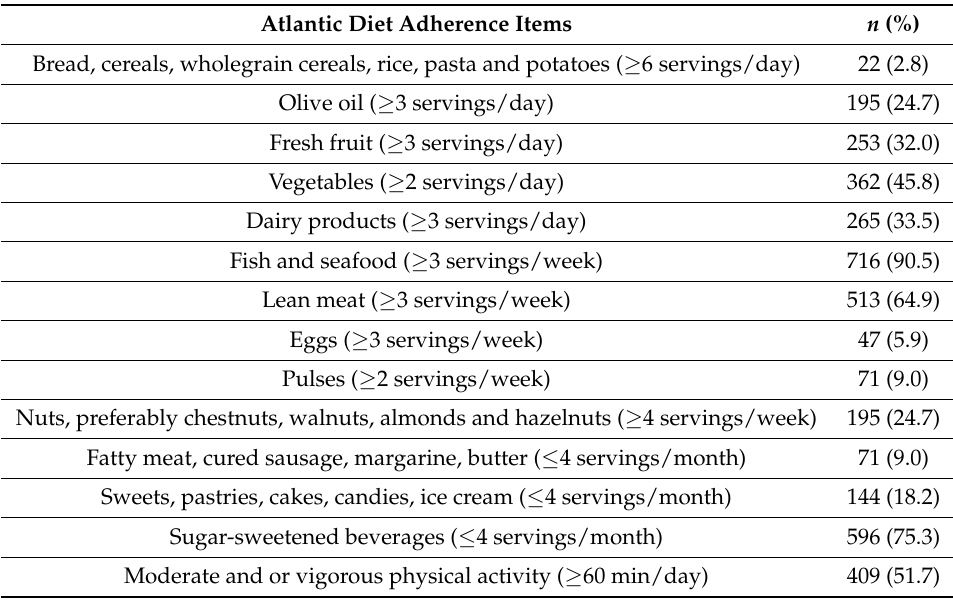
Table 3. Adherence to the ATLANTIC diet and lifestyle index.